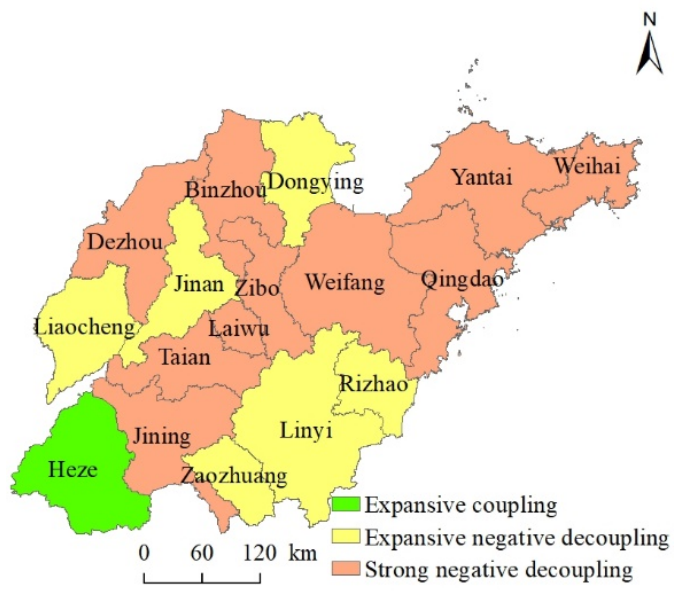
Figure 8. Spatial distribution of three types of rural human–land